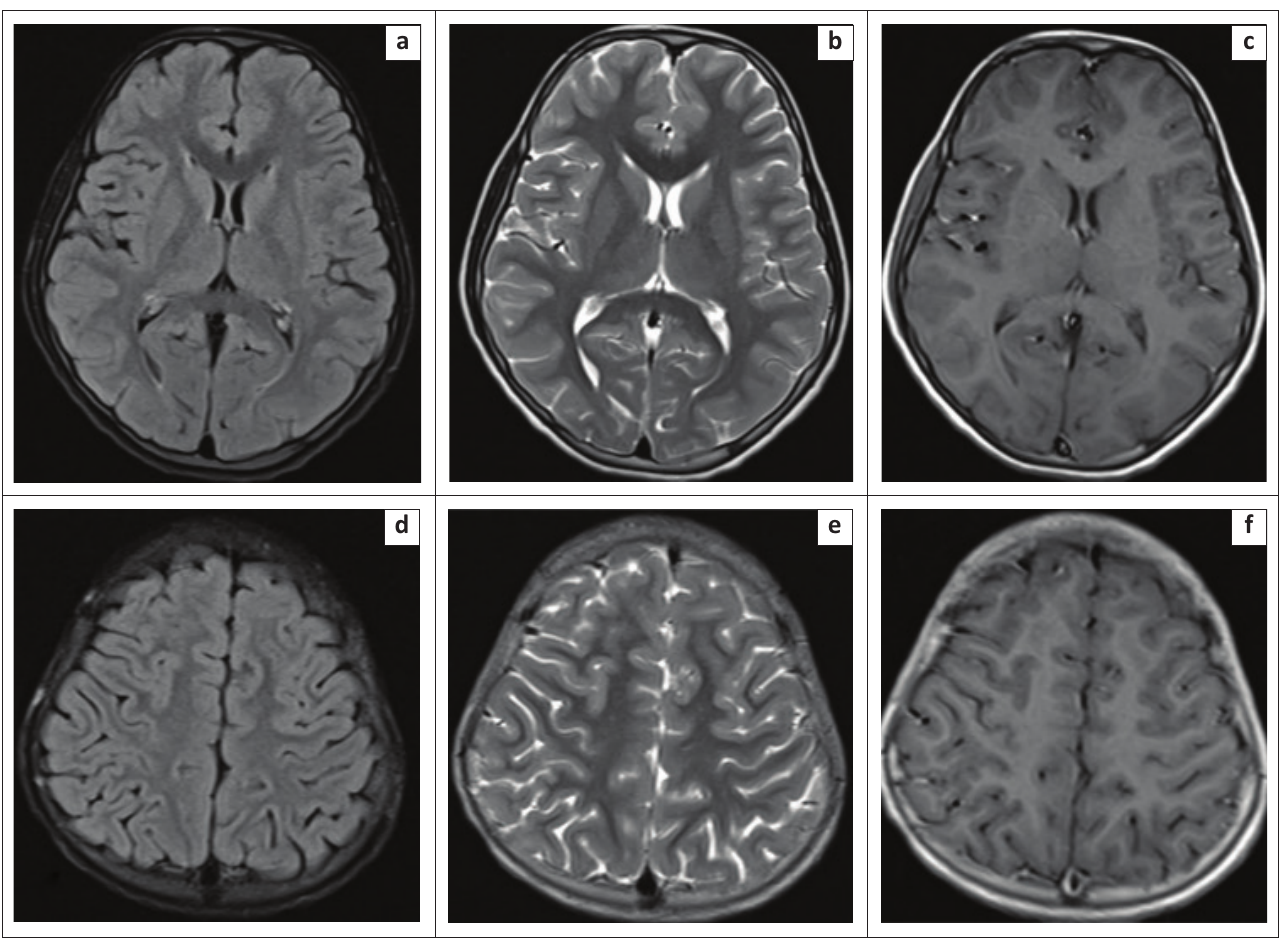
FIGURE 8: [Case 5]: Repeat brain MRI of a dengue seropositive 10-year-old female diagnosed with posterior reversible encephalopathy syndrome after 4 months showing complete resolution of the symmetrical signal abnormalities in the bilateral temporo-occipital and frontoparietal regions on axial FLAIR (a, d), T2-weighted (b, e) and T1- weighted (c, f)